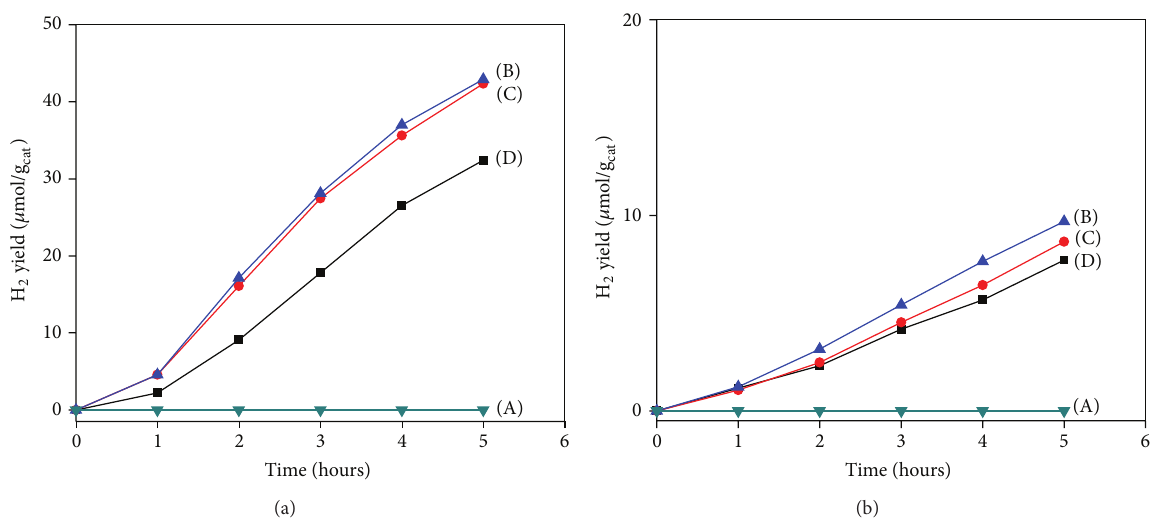
Figure 4: Photocatalytic splitting of (a) water and (b) seawater affected by CuO/nano-TiO 2 with (A) 0, (B) 12.5, (C) 25, and (D) 50mM of the oxalic acid sacrificial